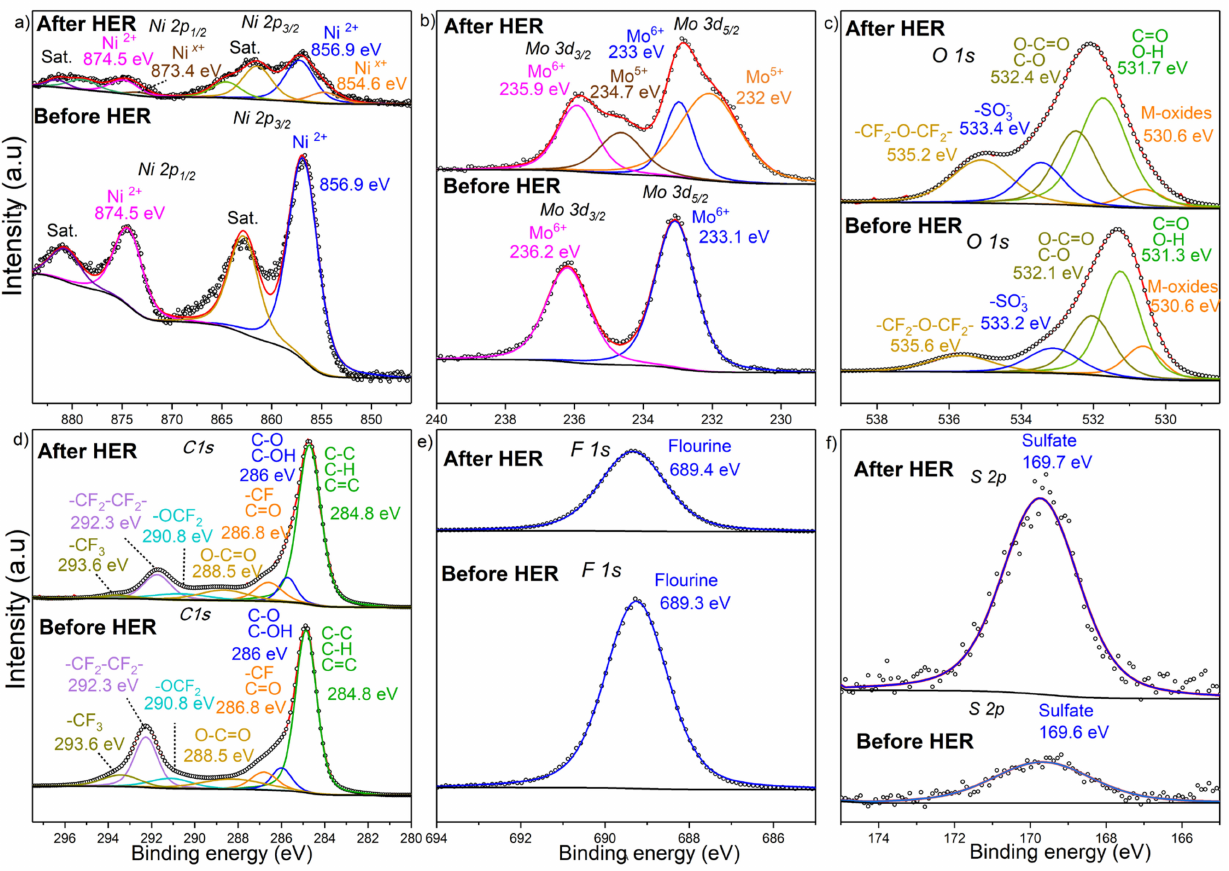
Figure 8. XPS analysis of the NiMoO 4 /CB/Nafion electrocatalyst layer (same specifications as those indicated in the caption of Figure 5) conducted before and after 24 h of electrolysis, performed at an overpotential of − 0.58 V, portraying the elemental scans of the electrocatalytic constituents: ( a ) Ni